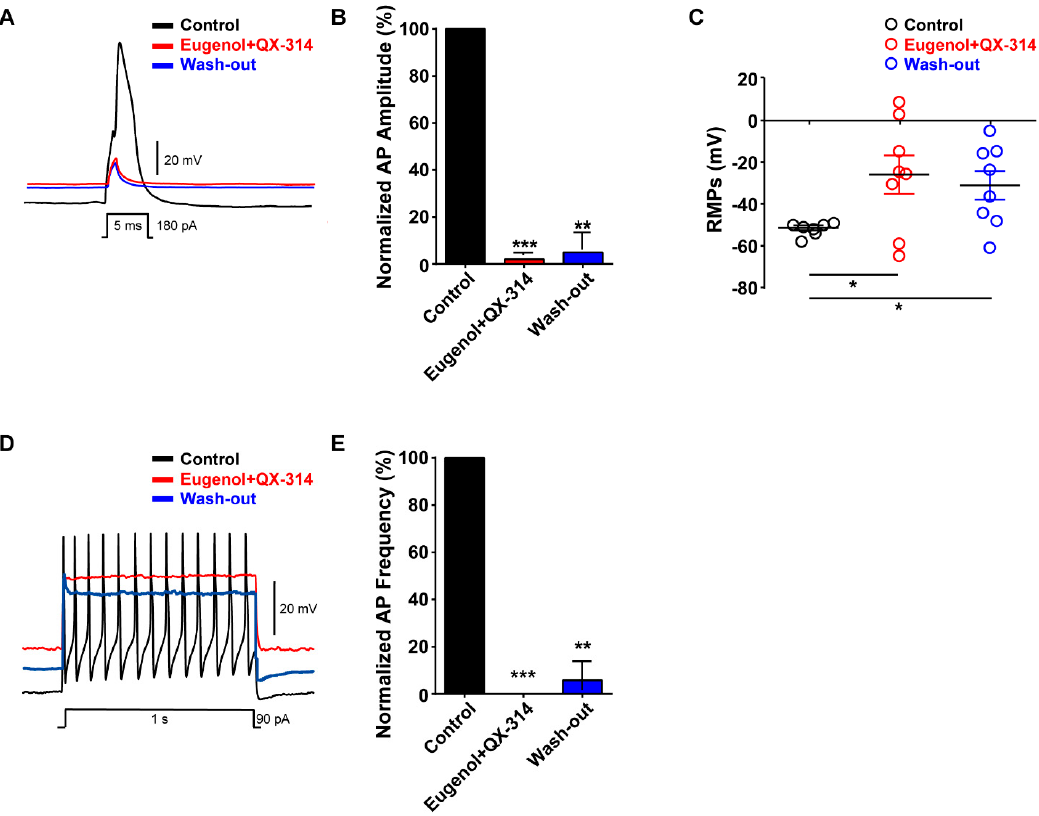
Figure 5. Effect of the co-administration of QX-314 and eugenol on APs in small-sized TG neurons. ( A ) Combination of eugenol (2 mM) and QX-314 (10 mM) completely abolished the AP generation even with current injection (180 pA, 5 ms). ( B ) Average percentage amplitudes of single APs after co-administration of eugenol and QX-314. ( C ) Average resting membrane potentials in the control, − 53 mV; after co-administration of eugenol and QX-314, − 26 mV; and after wash-out, − 31 mV. ( D ) Eugenol and QX-314 reduced the AP frequency, which remained blocked even after wash-out. ( E ) All data were normalized to control (black bar). Data are presented as mean ± standard error of the mean ( n = 8). Statistically significant differences from co-administration of eugenol and QX-314 or after wash-out in B and C. * p < 0.05 versus control, ** p < 0.01 versus control, *** p < 0.001 versus control.